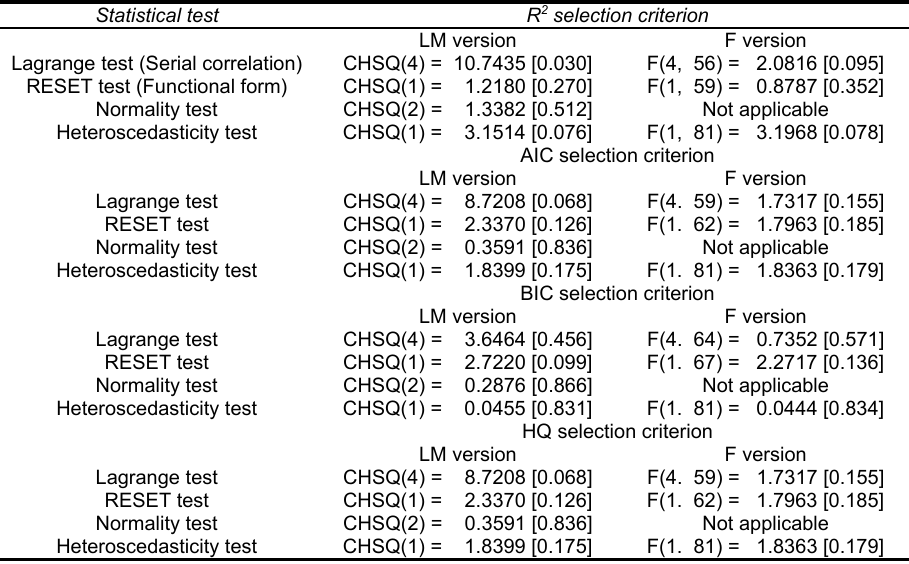
Table 4. Diagnostic tests considering unemployment rate as dependent variable Statistical